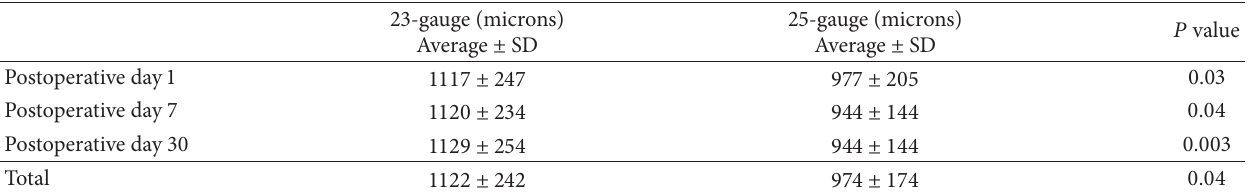
Table 1: Transversal length of sclerotomy incisions after transconjunctival sutureless pars plana vitrectomy performed with 23-gauge and 25-gauge measured with SD-OCT at the postoperative followup.